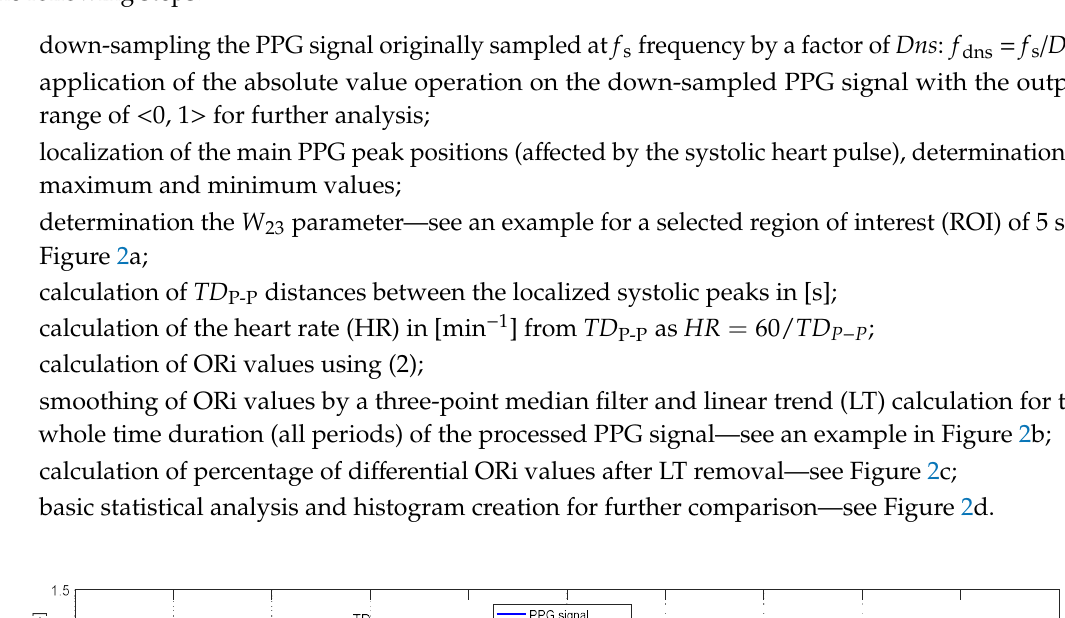
Figure 1. Principal structure of a photoplethysmographic (PPG) signal: ( a ) alternating current (AC) and direct current (DC) components superposition; ( b ) PPG volume pulse wave after signal processing (pre-filtering and DC component removal).